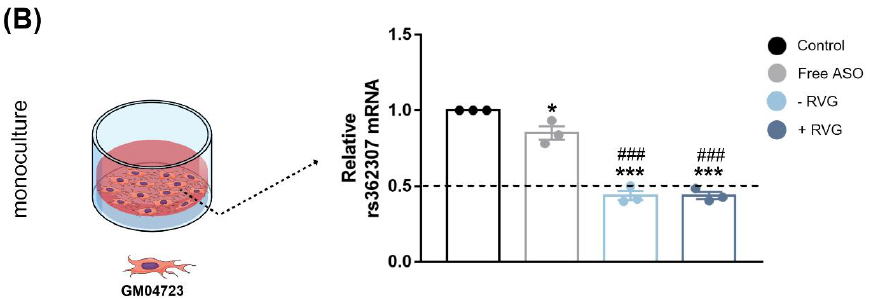
Figure 10. Evaluation of ASO efficacy after transfection with RVG-targeted and untargeted CDs in a co-culture and monoculture model. Schematic illustration of ( A ) the BBB co-culture model containing hCMEC/D3 cells in the apical compartment and HD-patient derived fibroblasts (CAG15/67) in the basal compartment and ( B ) monoculture of fibroblasts. SYBR Green RT-qPCR measurements of rs362307 (SNP1) mRNA levels in the fibroblasts following 72 h treatment with the ASO. Samples were normalized to human GAPDH, and data are the mean ± S.E.M of 3 technical replicates. * p < 0.05, and *** p < 0.001 compared to control; ## p < 0.01 and ### p < 0.001 compared to Free ASO; ˆˆ p <